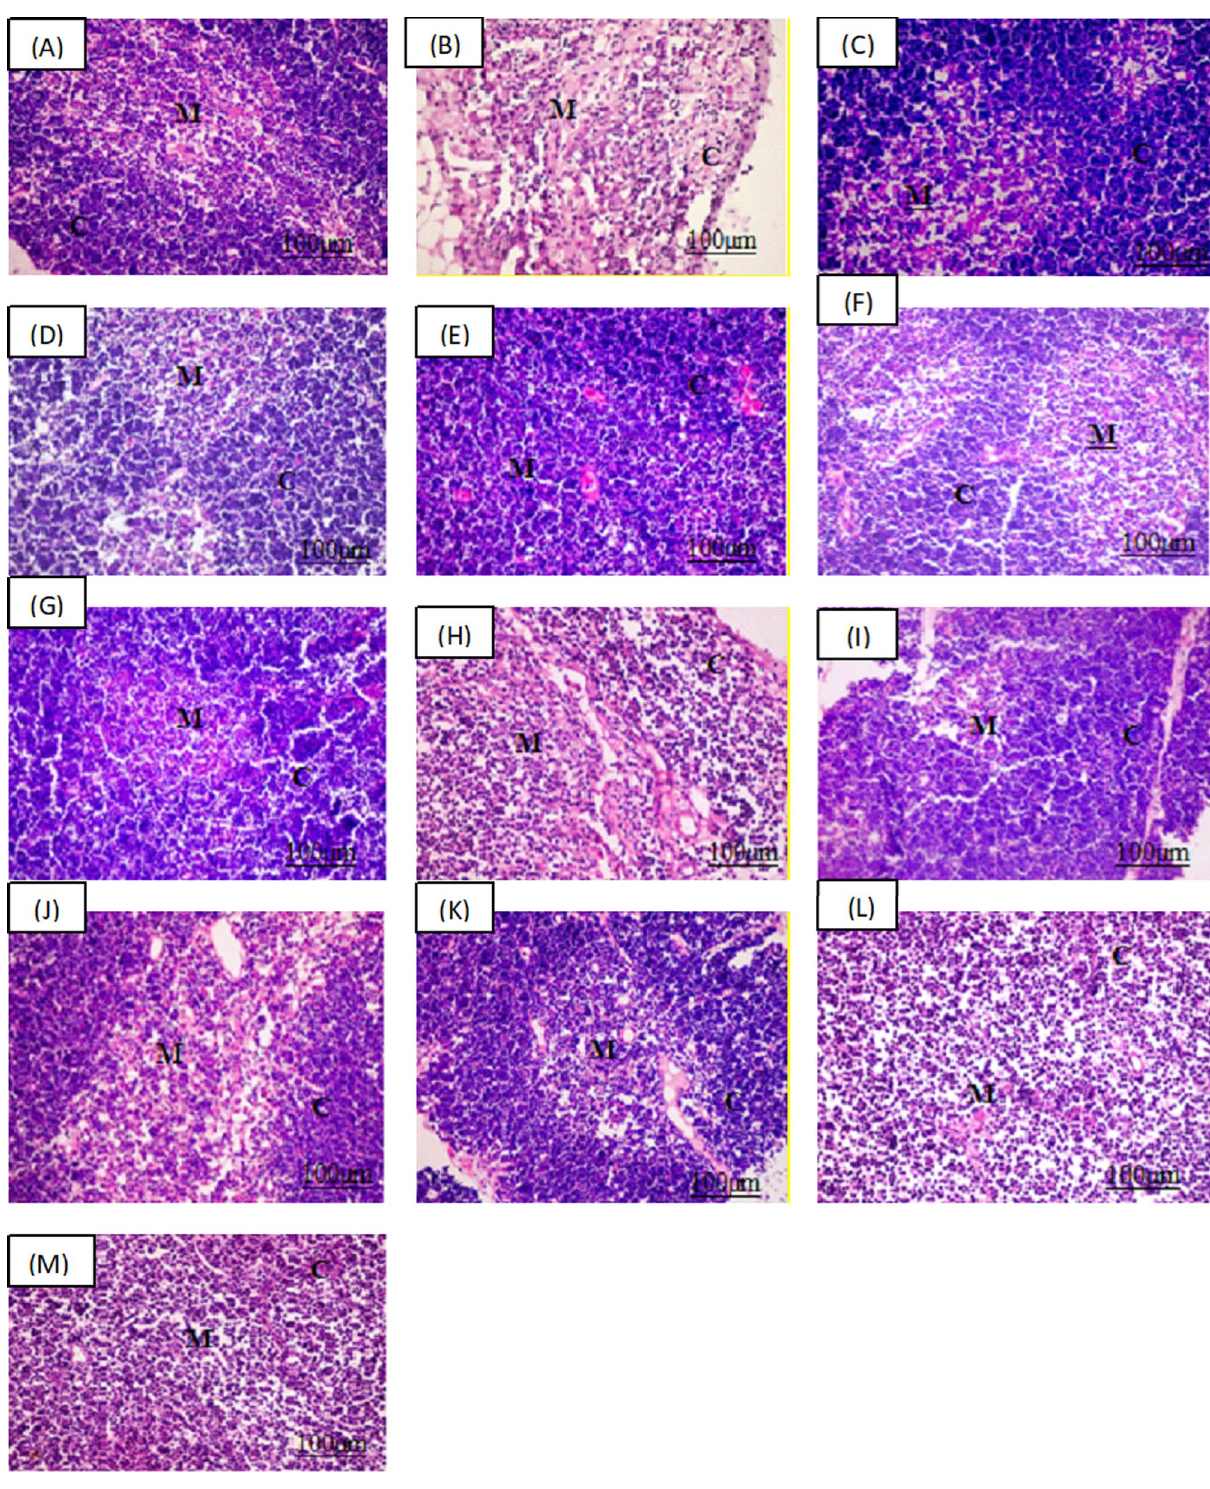
Figure 2. Histopathological findings of the thymus. Group 1 ( A ) for normal control group showed normal cortex ( C ) and medulla (M), Group 2 ( B ) for dexamethasone control group. Group 3 ( C ) for Echinacea extract treated group. Pleurotus ostreatus group for low dose (200 mg/Kg) Group 4 ( D ) and high dose (400 mg/Kg) Group 5 ( E ). Pleurotus columbinu s low dose (200 mg/Kg) Group 6 ( F ) and high dose (400 mg/Kg) Group 7 ( G ). Pleurotus sajor-caju for low dose (200 mg/Kg) Group 8 ( H ) and high dose (400 mg/Kg) Group 9 ( I ). Lentinula edodes low dose (200 mg/Kg) Group 10 ( J ) and high dose Group (400 mg/Kg) 11 ( K ). Agaricus bisporus low dose (200 mg/Kg) Group 12 ( L ) and high dose (400 mg/Kg) Group 13 ( M ).